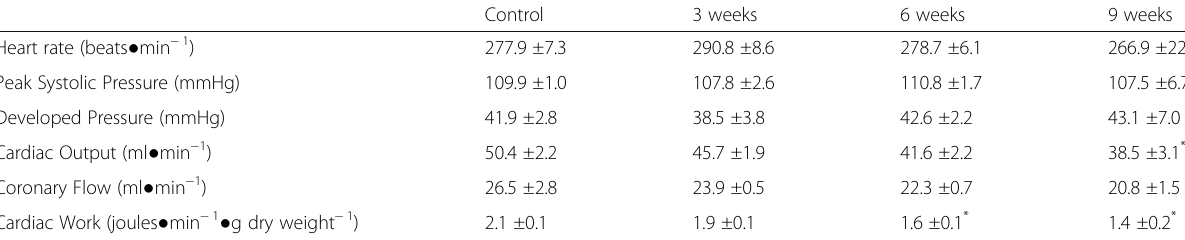
Table 2 Effect of a high salt diet (HSD) on cardiac function ex vivo in Dahl salt-sensitive